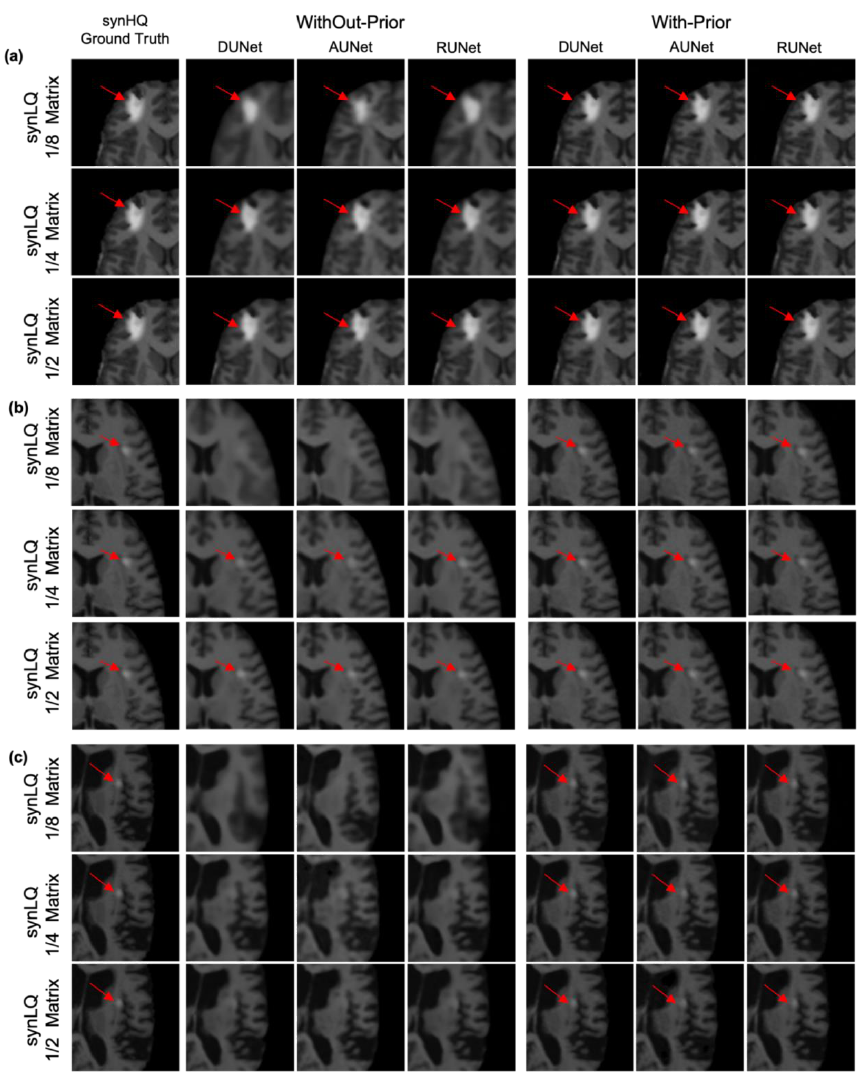
Figure 10. Characteristic examples of upscaling a 1/8 downsampled (22 × 26), a 1/4 downsampled (44 × 52) and a 1/2 downsampled (88 × 104) synLQ image, of the same set) toward the synHQ ground truth. The figure shows a comparison of two acquisition scenarios: With-Prior and